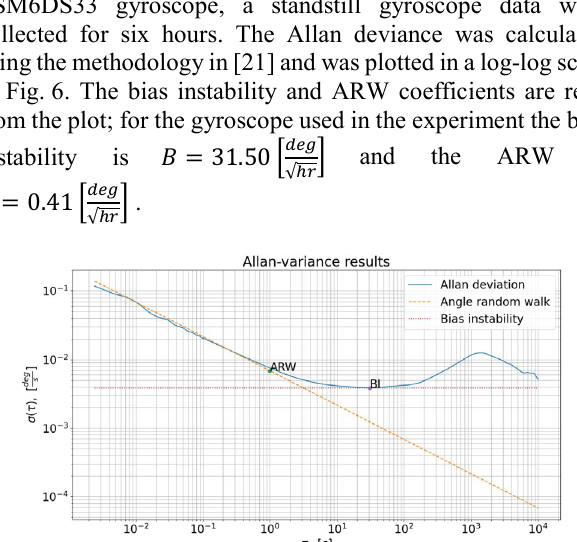
Fig. 6. The Allan variance